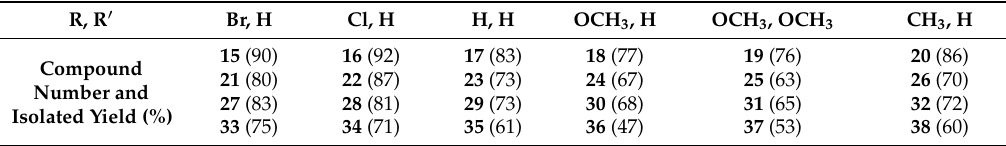
Table 1. Synthesis of pyrazolines ( 15 – 38 ) via cyclocondensation reactions.